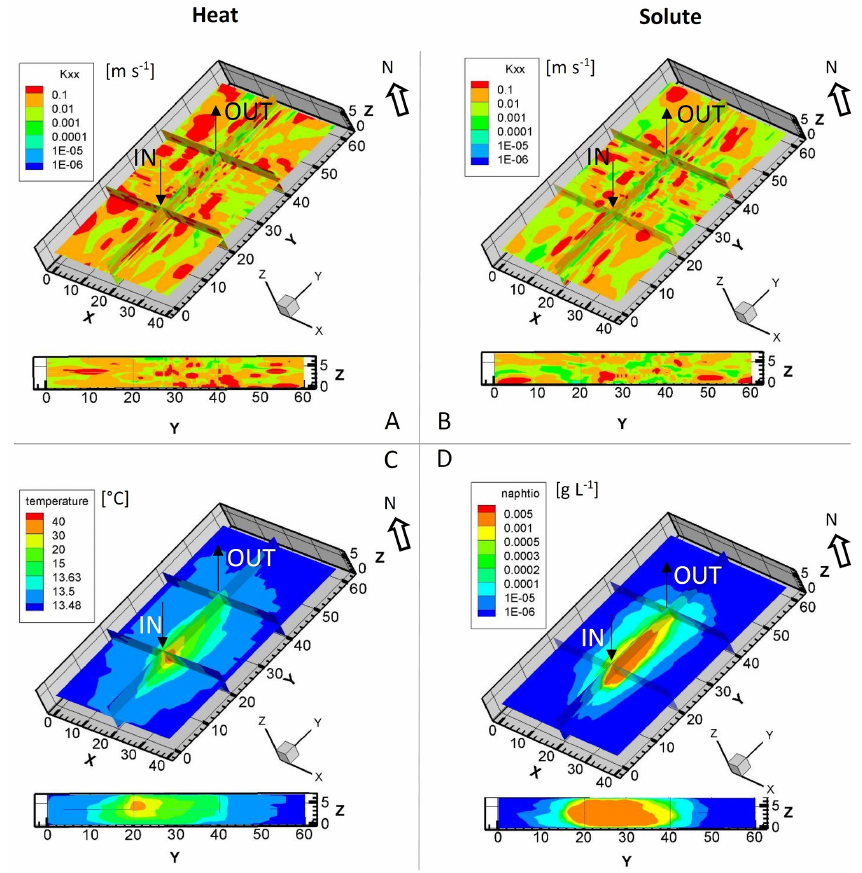
Figure 3. Hydraulic conductivity fields (a, b) and related simulations (c, d) obtained by inversion of temperature (a–c) and solute tracer concentration data (b–d) from heat and solute tracer experiments (modified from Hoffmann et al., 2019, Table